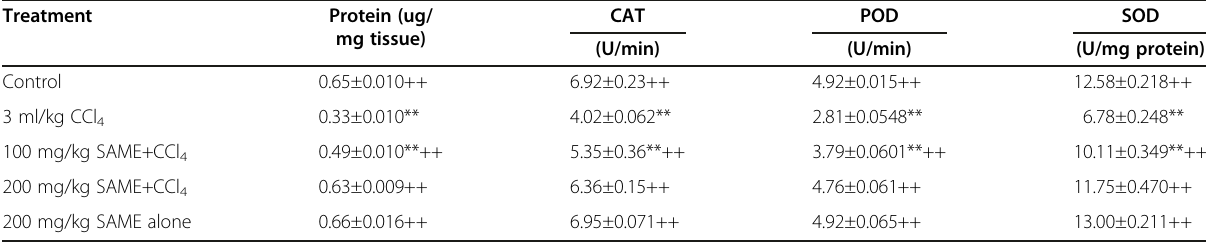
Table 2 Effect of SAME on thyroid hormones tissue protein, CAT, POD, SOD activities